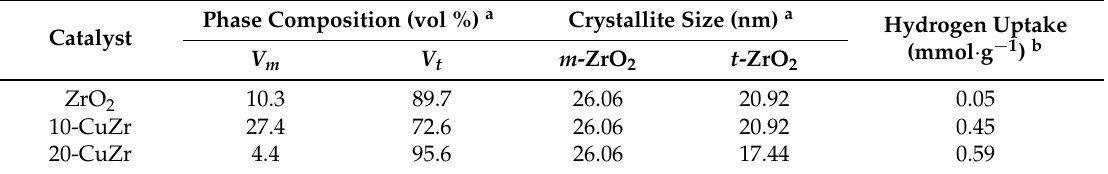
Table 1. Results from XRD and H 2 -Temperature programmed reduction (H 2 -TPR)